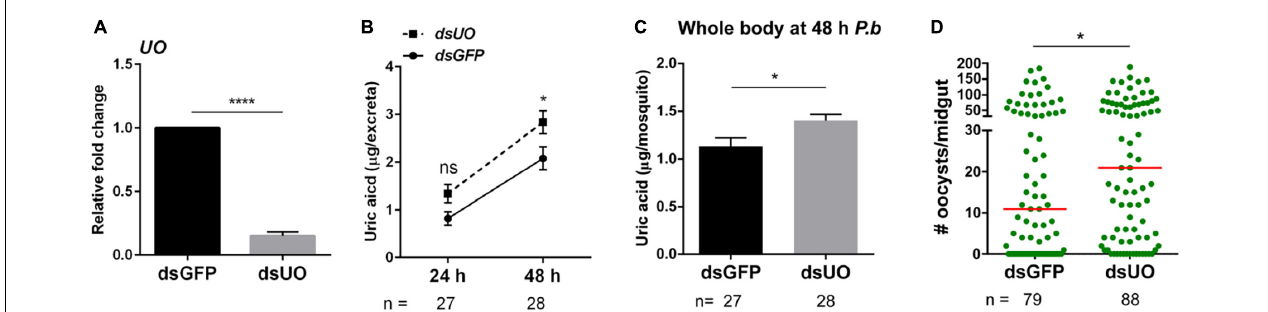
FIGURE 3 | Urate oxidase ( UO ) silencing increases uric acid levels and Plasmodium oocyst survival. To determine whether accumulation of uric acid in the mosquito promotes the success of oocyst survival, Urate oxidase ( UO ) silencing was validated by qRT-PCR 2 days post-injection of dsRNA (A) , resulting in the increase in uric acid measured in excreta (B) and whole mosquitoes (C) as compared to dsGFP controls. When UO -silenced mosquitoes were challenged with P. berghei , we observed a significant increase in oocyst survival when compared to GFP controls at 8 days post-infection (D) . qRT-PCR and whole mosquito uric acid data were analyzed using an unpaired t -test, while uric acid excreta data were analyzed using a two-way repeated-measures ANOVA followed by Sidak’s multiple comparison test. Data are displayed as the mean ± SEM of three independent experiments. Differences in oocyst survival were analyzed using Mann–Whitney analysis, with